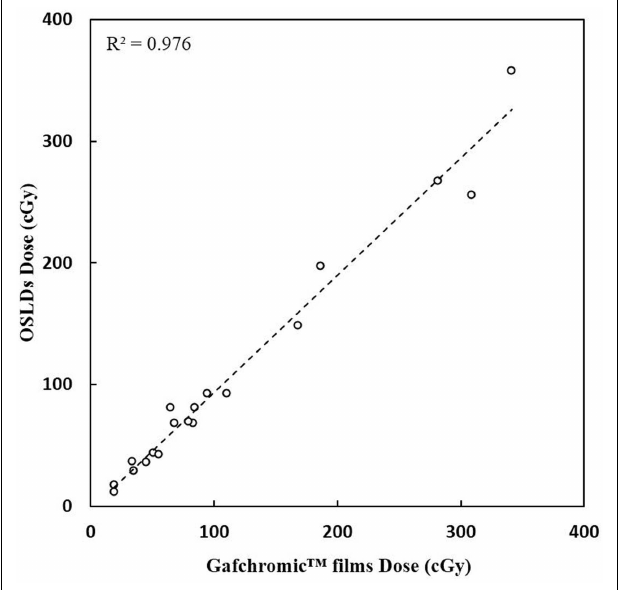
Table 1 | Mean heart dose measured with Gafchromic films for the medium (800cc) and large breast (1200cc) phantom using different radiation techniques